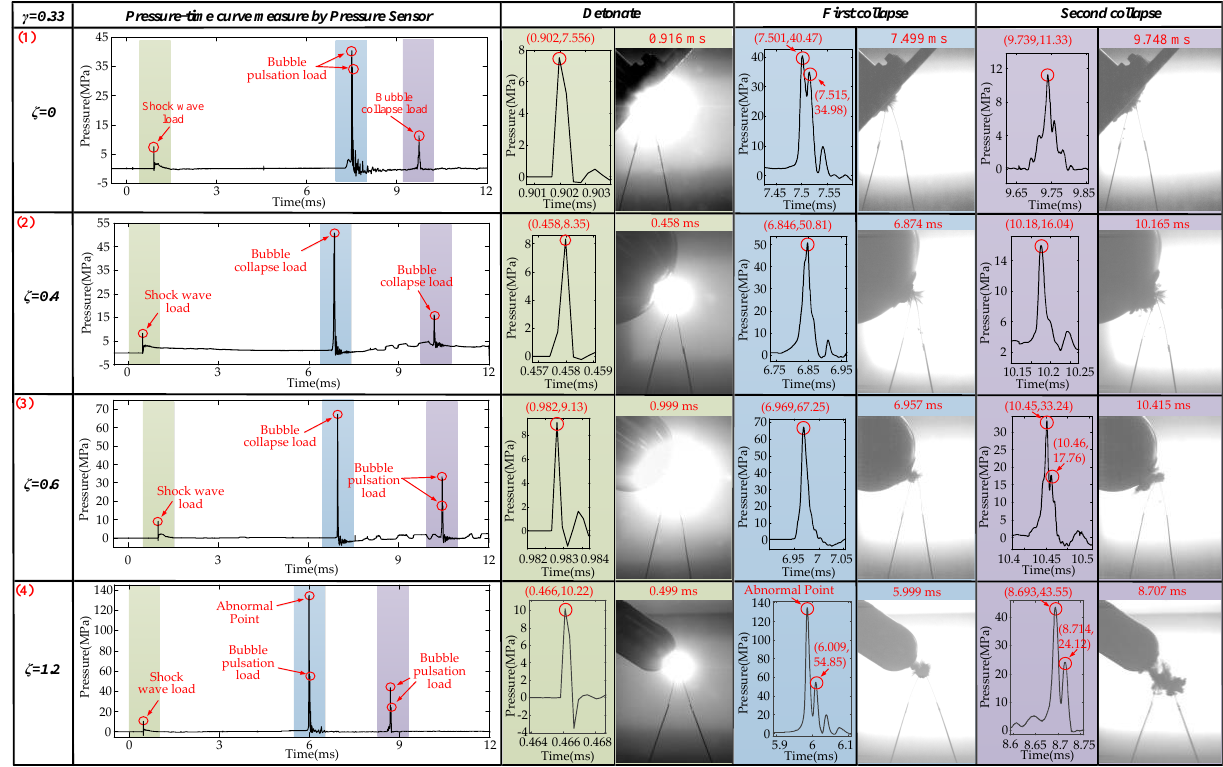
Figure 17. Pressure-time diagram for γ = 0.33 and different ζ values. ( 1 ) The first row shows the pressure–time curves for the states of ζ = 0 and γ = 0.33. ( 2 ) The second row shows the pressure–time curves for the states of ζ = 0.4 and γ = 0.33. ( 3 ) The third row shows the pressure–time curves for the states of ζ = 0.6 and γ = 0.33. ( 4 ) The fourth row shows the pressure–time curves for the states of ζ = 1.2 and γ = 0.33.